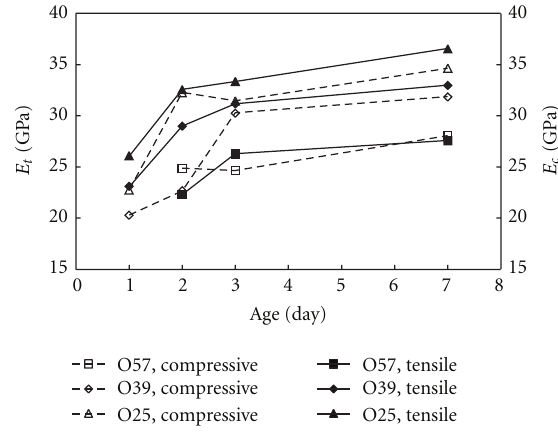
Figure 9: Strengths versus age of concrete. Figure 10: Young’s moduli versus age of concrete.